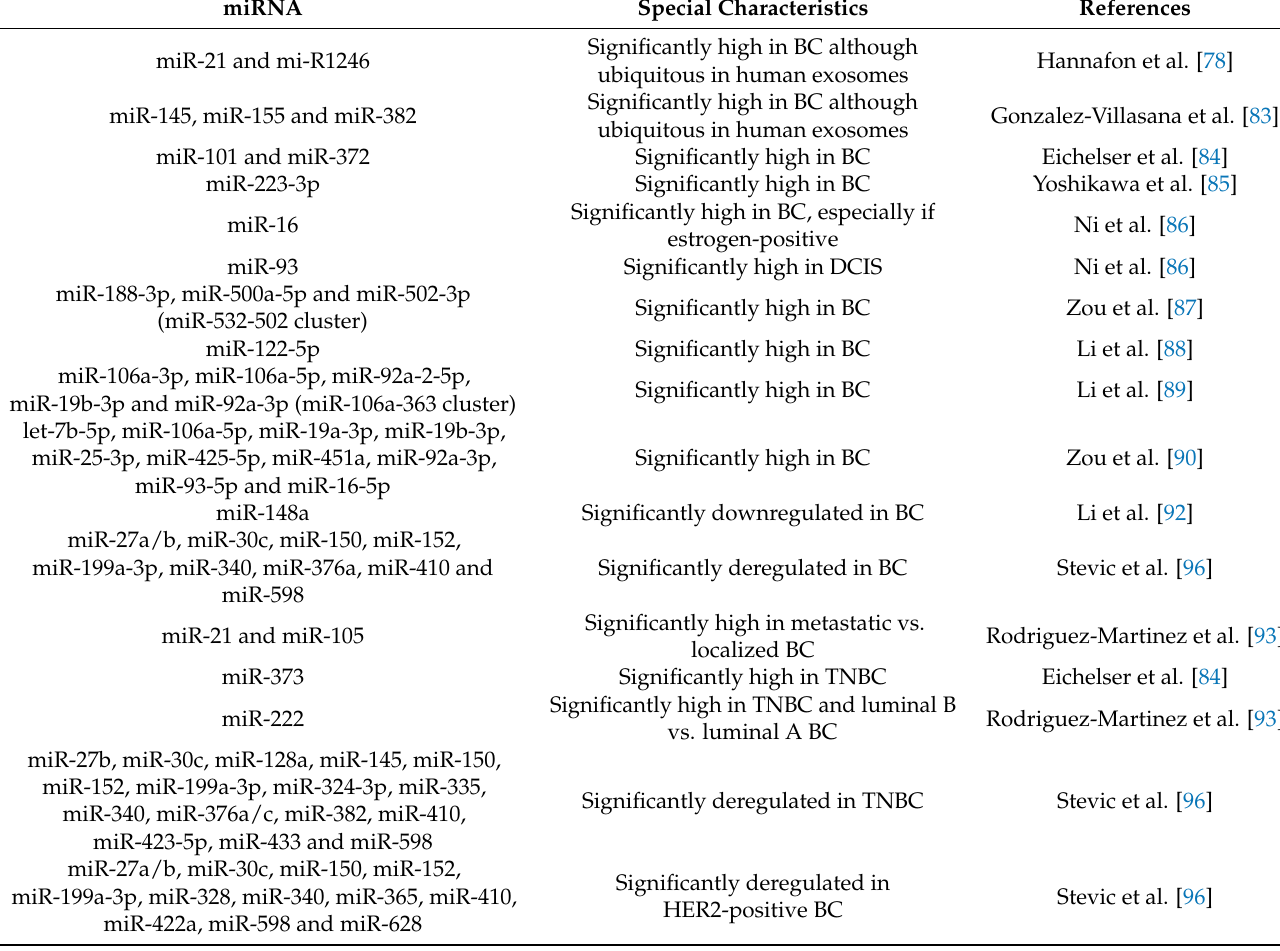
Table 1. Exosomal miRNA detected in serum or plasma of BC patients that could be useful for early diagnosis. miRNA Special